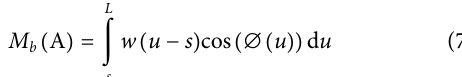
The curvature was calculated from f ’ ( x ) and f ’’ ( x ), the fi rst and second derivatives of f ( x ) with respect to x :